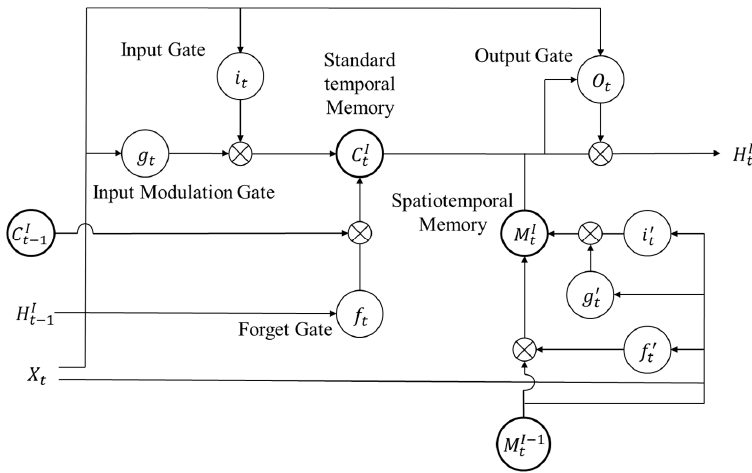
Figure 5. Spatiotemporal-long short-term memory (LSTM) architecture.